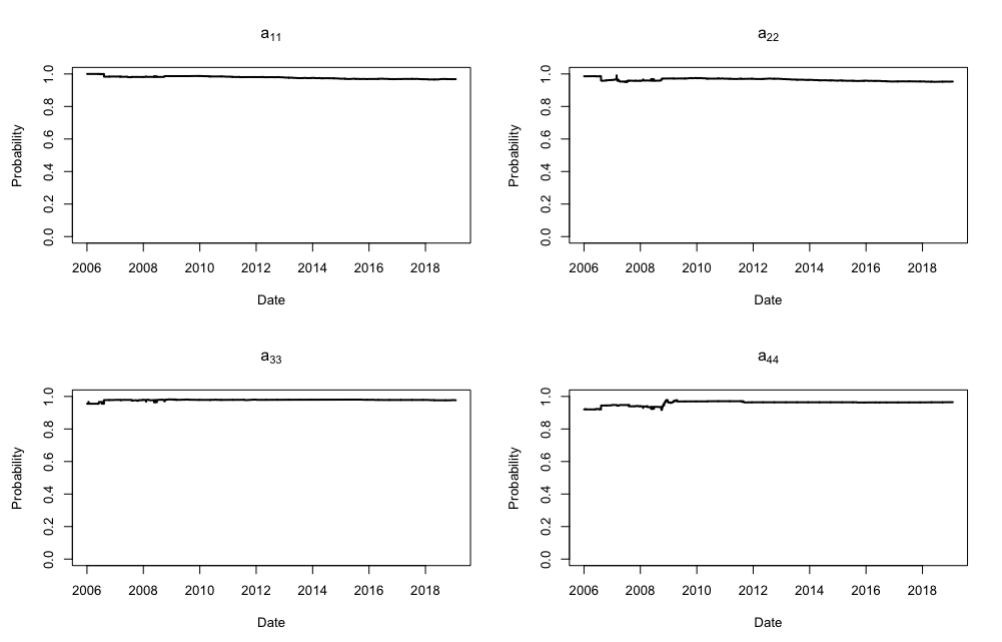
Figure 11. Expanding window: state persistence for the homogeneous four-state normal HMM on S and P 500 daily log returns.